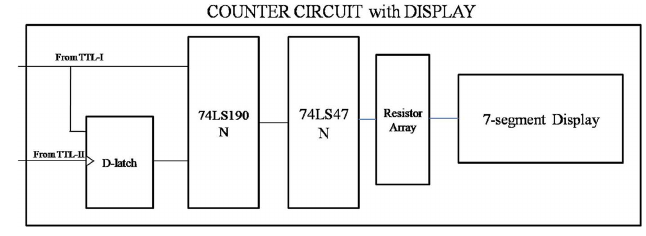
Figure 7 Block diagram of the counter circuit.